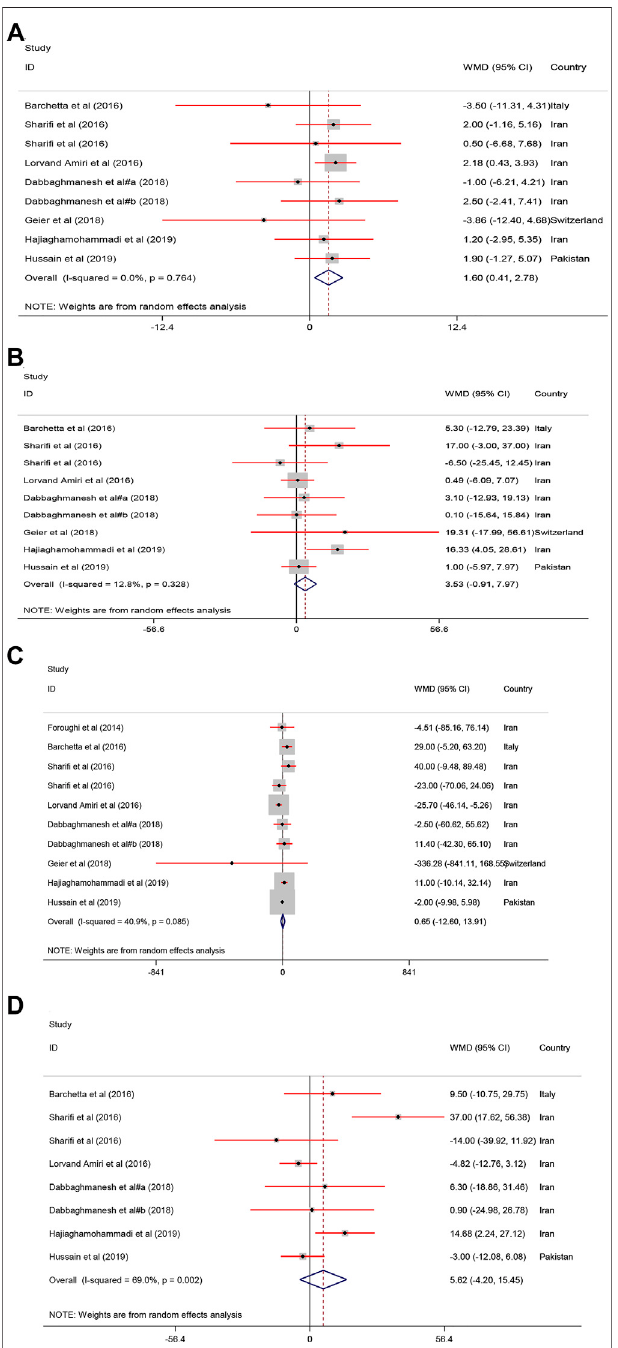
FIGURE 3 | The anthropometric parameters standardized mean differences estimates for (A) BMI, (B) weight, and (C) body fat and (D) WC between intervention group (receiving vitamin D supplementation) and placebo